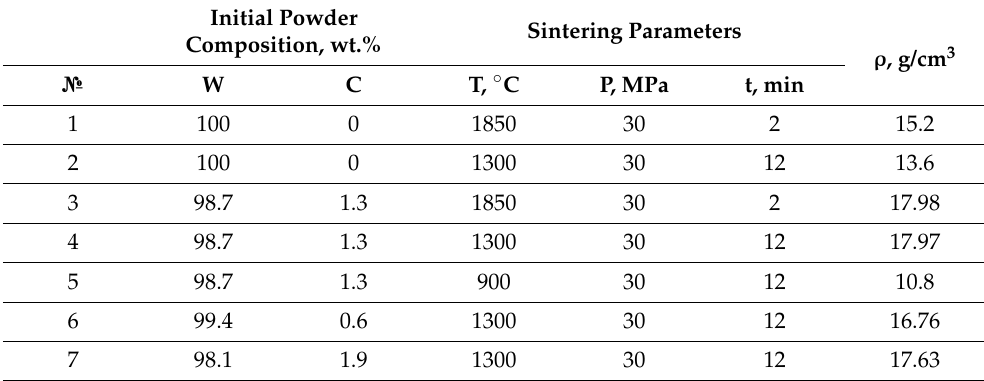
Table 1. The composition, sintering parameters, and density of the samples. Initial Powder Sintering Composition, wt.%